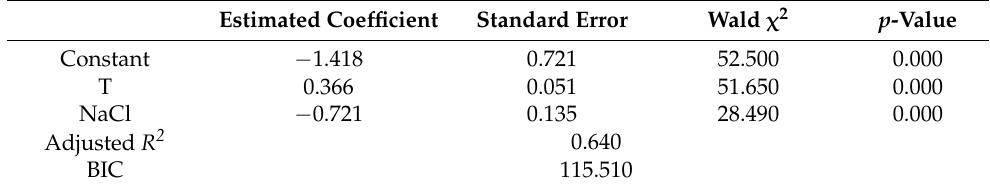
Table 1. Logistic regression of combined effect of T, pH, and NaCl on adhesion probability of L. monocytogenes